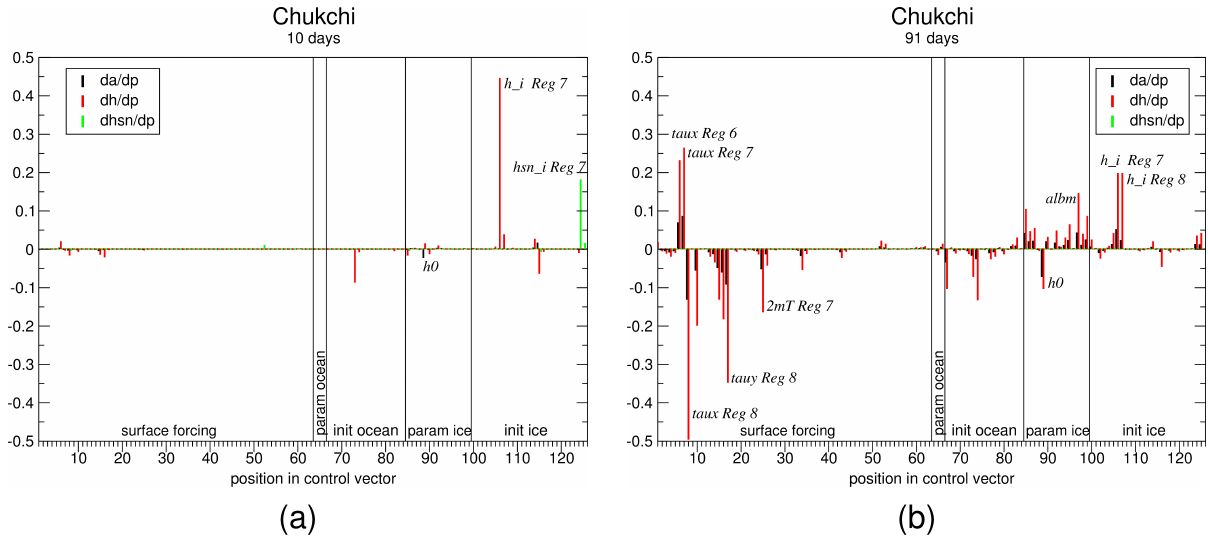
Figure 4. Sensitivity of target quantities over Chukchi area for 10-day (a) and 91-day (b) forecasts to 1 prior sigma uncertainty change in each control variable. Units of target quantities (and their sensitivities): ice concentration (a) (0–1); ice thickness (h) in metres; snow thickness ( hsn ) in metres.